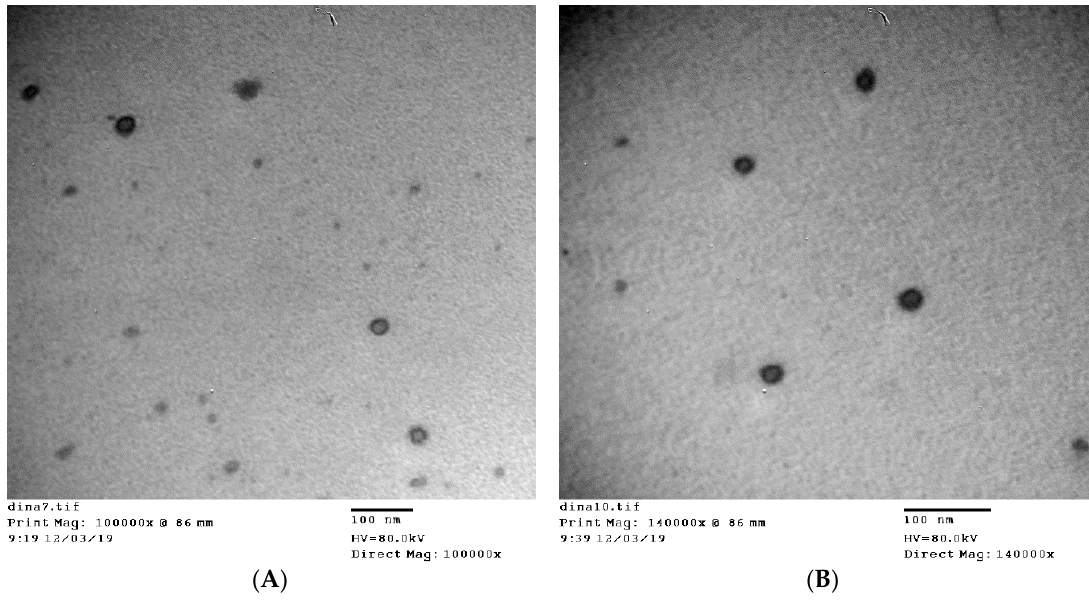
Figure 1. TEM photomicrographs of liposome formulation L5 ( A ) and ethosome formulation E4 ( B ).